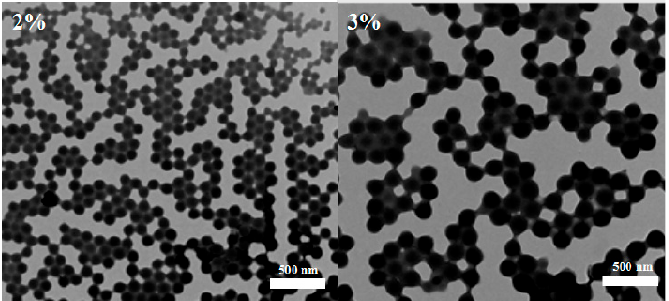
Figure 3. TEM micrographs of PLA nanoparticles prepared under different PVA concentrations (2% and 3%).